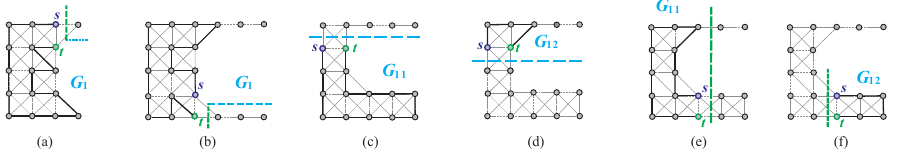
Figure 25. The longest ( s , t ) -path under that a (cid:62) 2 and c = 1, where ( a , b ) (UB7) holds, ( c , d ) (UB8) holds, and ( e , f ) (UB9) holds.